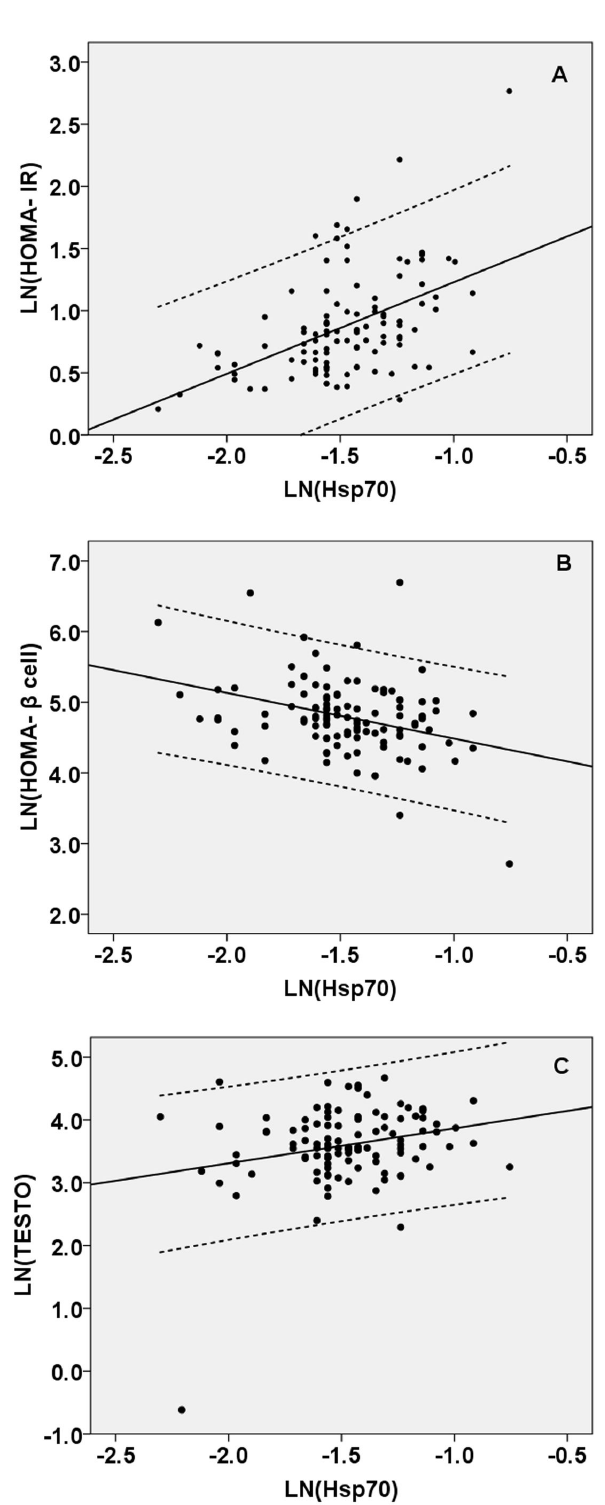
Figure 2. Correlations between the log-transformed serum Hsp70 levels and HOMA-IR (A), HOMA-β cell (B), TESTO (C) for PCOS. Scatter plot demonstrating a significant correlation between the log-transformed serum Hsp 70 levels (ng/ml) and log- transformed HOMA-IR (A) (r = 0.488, P < 0.001), HOMA-β cell (B) (r = -0.388, P = 0.009) and TESTO (C) (r = 0.250, P < 0.001) in patients with PCOS, respectively. doi: 10.1371/journal.pone.0067727.g002 PLOS ONE |